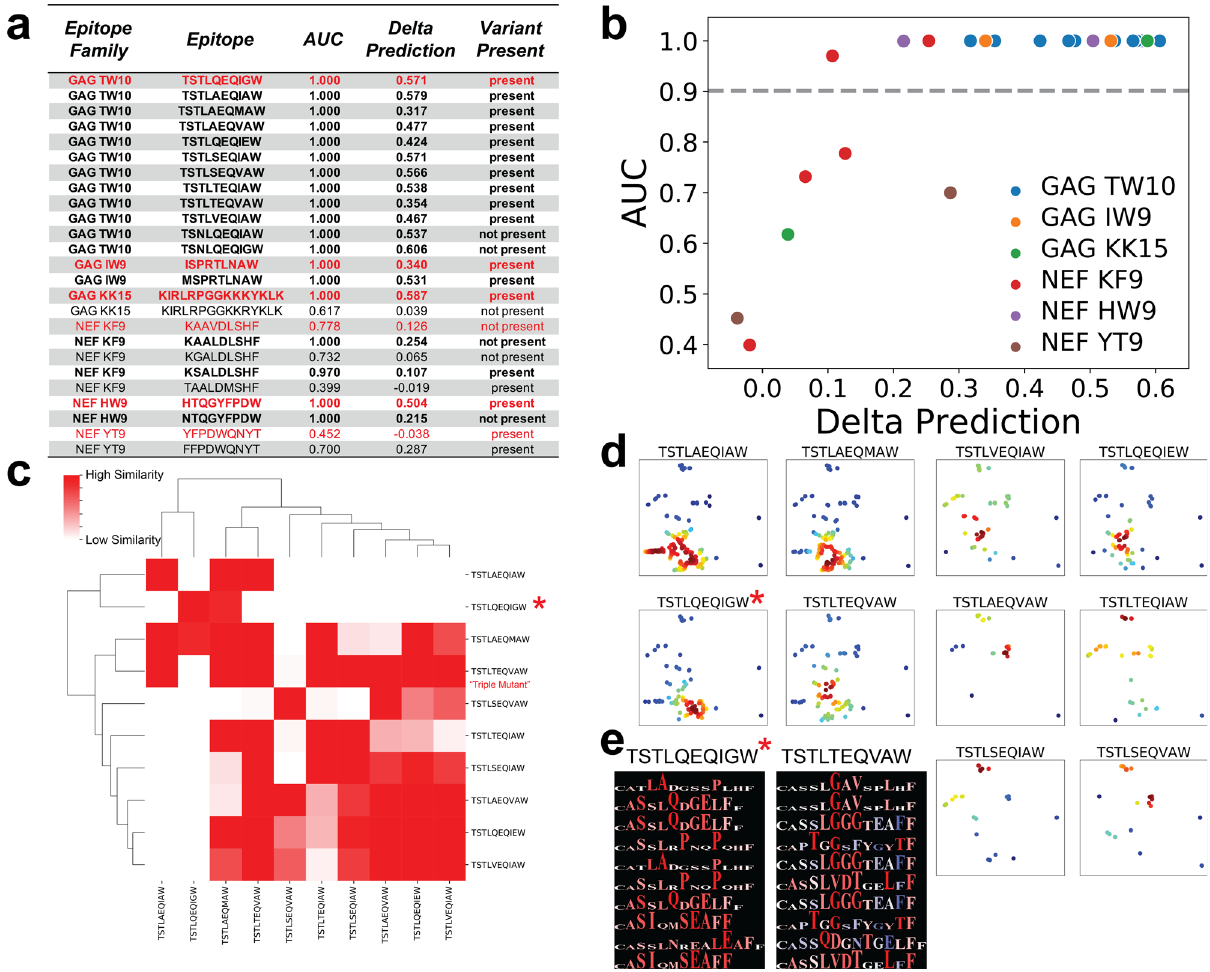
Fig. 5 Characterization of TCR repertoire to HIV-speci fi c epitopes. a Table summarizing results from all epitopes screened for antigen-speci fi c immune responses via DeepTCR repertoire classi fi er. Consensus epitopes are denoted in red. Epitopes that were considered to be statistically signi fi cant for antigen- speci fi c expansion via AUC> 0.90 are denoted in bold lettering. b Delta Predictions vs AUC shown for all epitopes screened for antigen-speci fi c immune responses via DeepTCRs repertoire classi fi er. c All detected variants in ES8 for the GAG TW10 epitope family were collected and DeepTCRs repertoire classi fi er was ran for all pairwise combinations of these variants. 1-Delta Predictions are plotted in clustered heatmap for simultaneous comparison of immune repertoires where a large value denotes similarity between repertoires. * denotes the consensus sequence. d DeepTCR sequence classi fi er was trained in a multi-class fashion (Supplementary Fig. 15) on the positive predicted sequences (prob > 0.99) from the initial screen against non-cognate epitopes to learn TCR sequence-speci fi c features that could distinguish responses between variants of the GAG TW10 epitope family. UMAP dimensionality reduction was applied to the per-sequence prediction values to generate visualizations for the antigen-speci fi c TCRs. Intensity of coloring corresponds to density as computed by Gaussian kernel density estimation. e Residue Sensitivity Logos were produced for the consensus and triple-mutant epitope to highlight structural differences of the immune